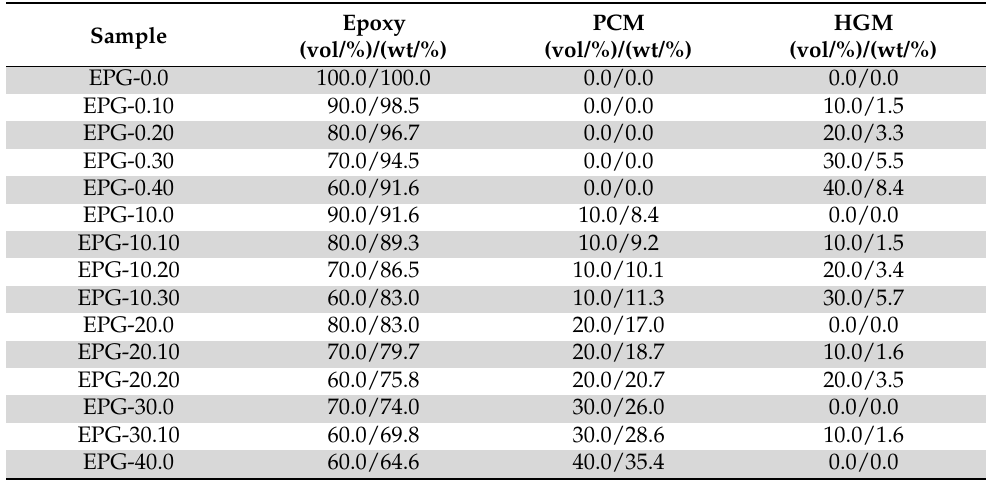
Table 1. List and code of the prepared syntactic foams with their relative composition of epoxy matrix, phase change material (PCM), and hollow glass microsphere